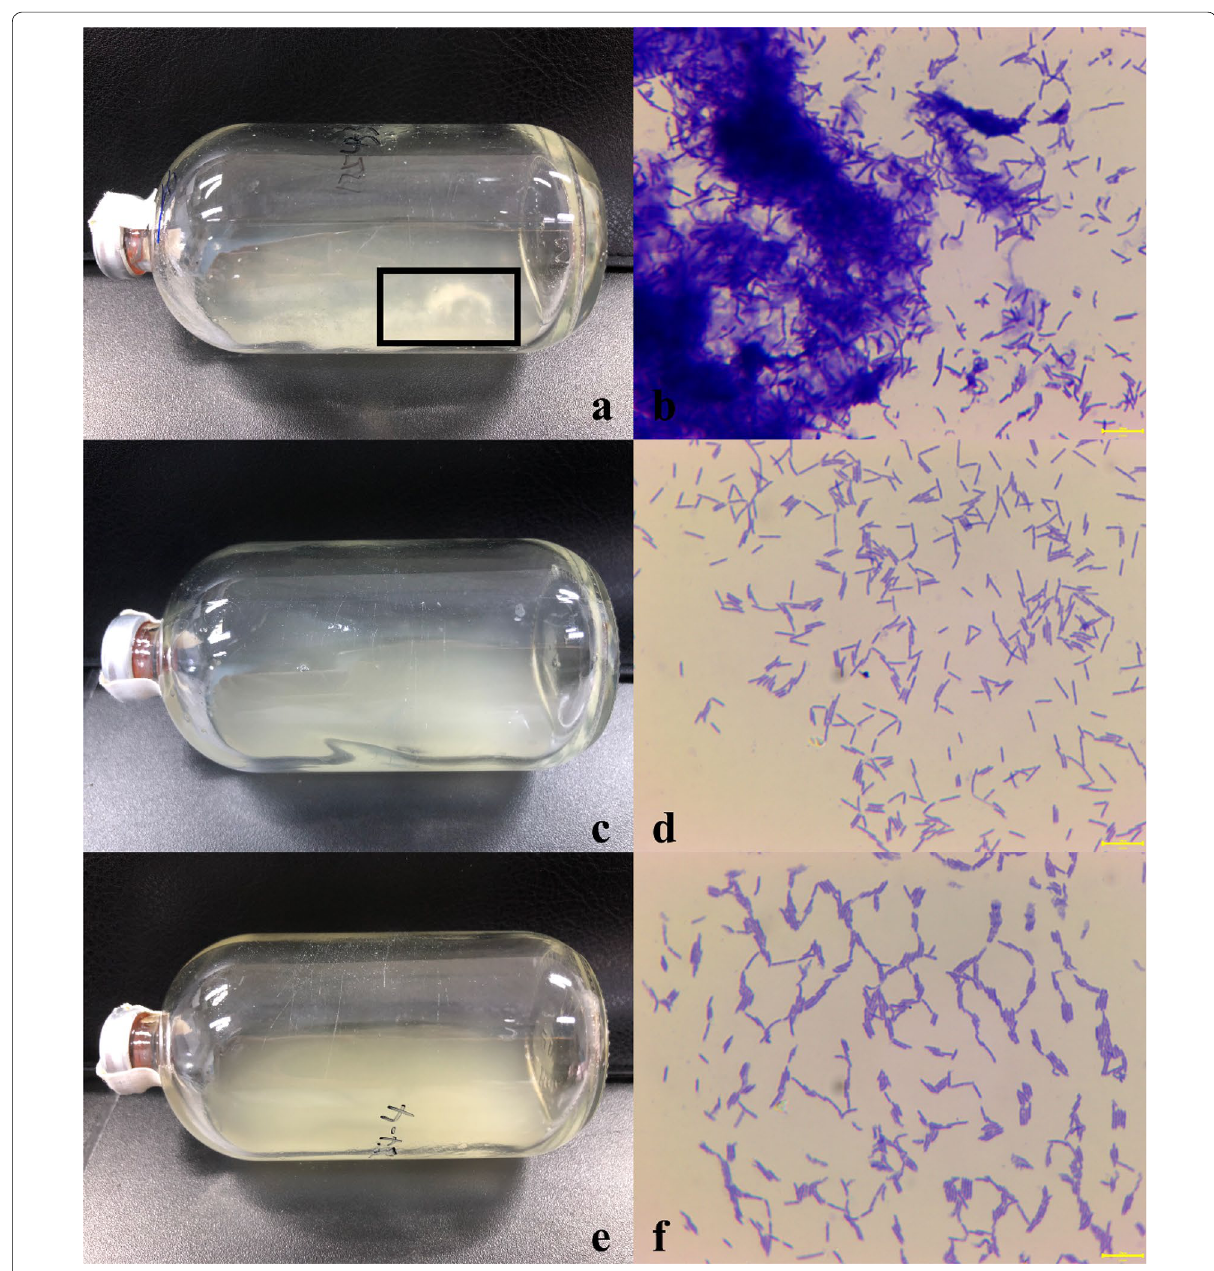
Fig. 2 The morphologic pictures of C. carboxidivorans P7 in serum bottle and under the microscope using various temperature strategies. The broth in serum bottle in the late culture stage of a 37 °C, c 25 °C and e 37–25 °C, respectively. The microscopic examination of the corresponding broth in the late culture stage of b 37 °C, d 25 °C and f 37–25 °C, respectively, using methylene blue staining (1000